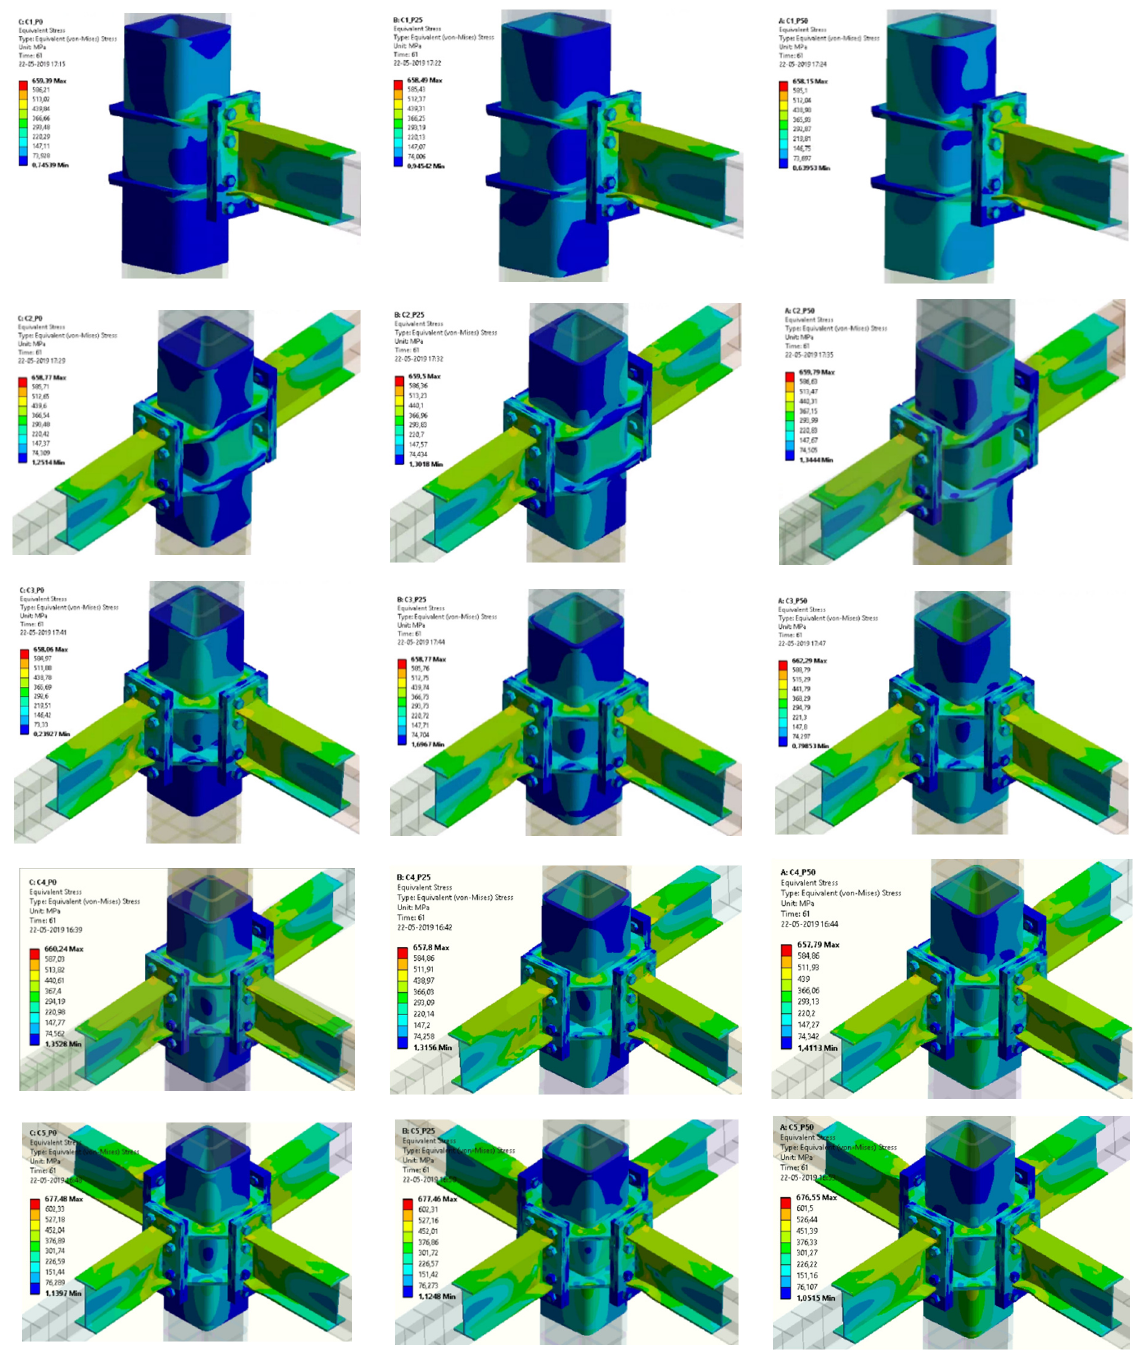
Figure 10. Distribution of Von Mises stresses in joints.